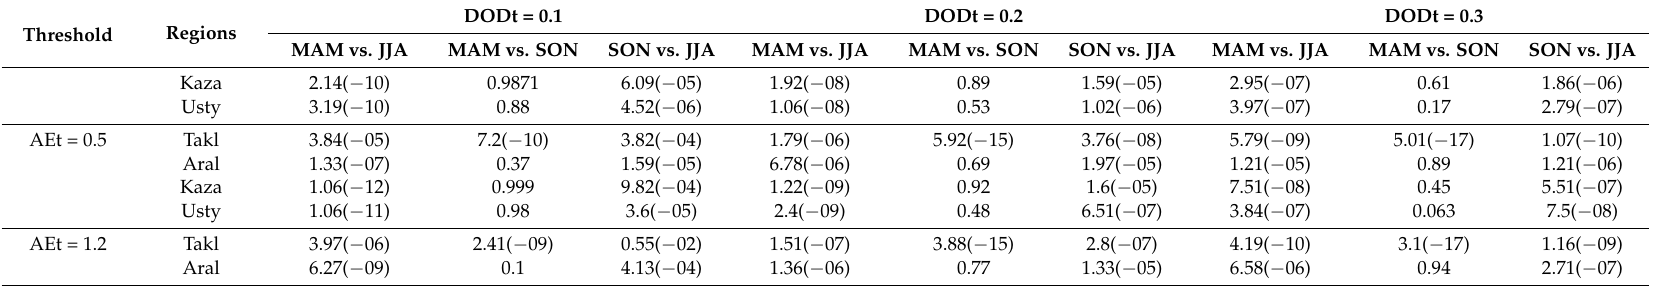
Table 4. p -values from the Wilcoxon sum rank test on the seasonal variation of dust occurrence that derived using several criteria: AEt = 0.5 and AEt = 1.2 against DODt = 0.1, DODt = 0.2, and DODt = 0.3 over the four sub-regions, as shown by boxes in Figure 1. Note for instance, 2.14 stands for 2.14 × 10 − 10